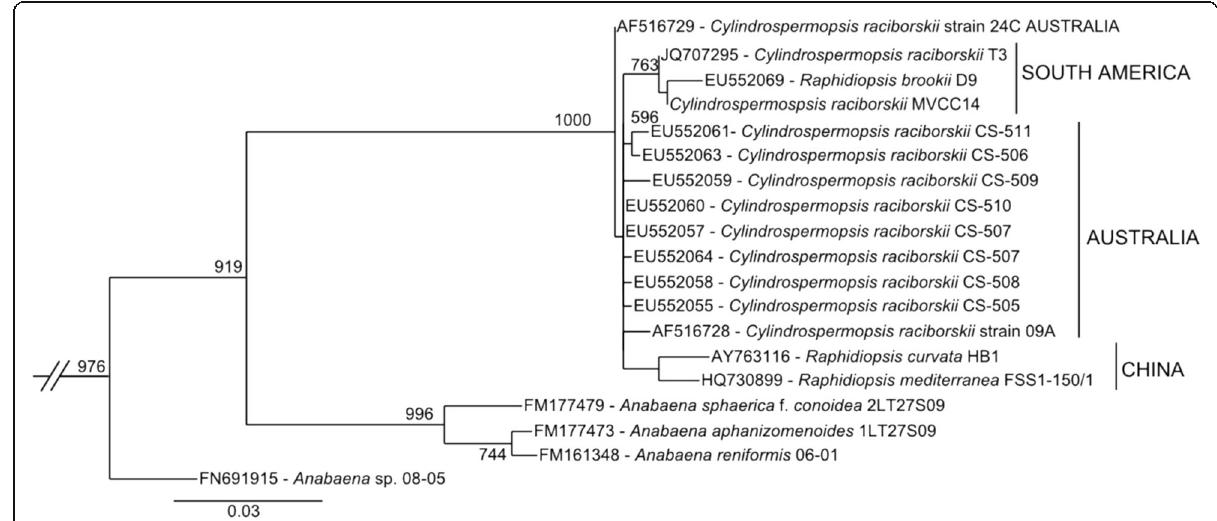
Fig. 2 Maximum likelihood (ML) phylogenetic tree indicating the phylogenetic relationship of C. raciborskii strains. The ML tree is based on 16S rRNA gene sequences from C. raciborskii strains CS-508 and MVCC14 and sequences retrieved from previous reports stored in the NCBI database. These sequences were aligned using MUSCLE [43] and the phylogenetic tree was constructed with the phyML using GTR substitution model and BEST option for searching the starting tree [44]. Bootstrap support values ≥ 50% are indicated from 1000 bootstrap replicates. In supplemental material a complete phylogenetic tree is reported (Additional file 1: Figure